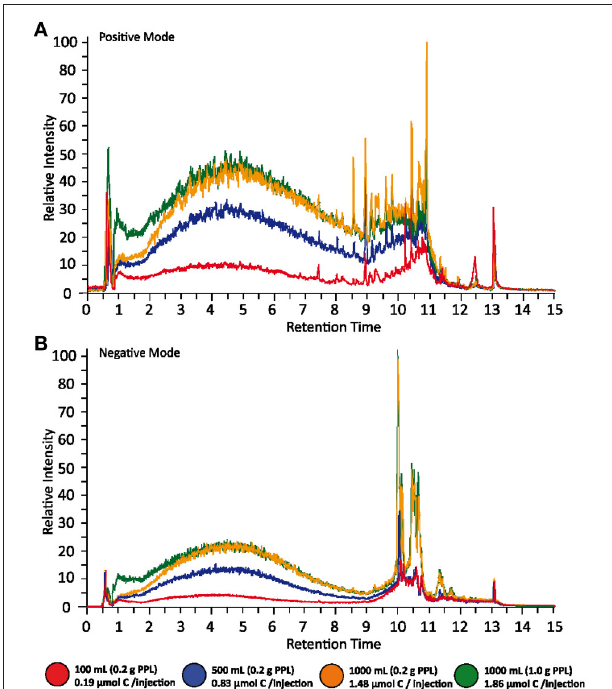
FIGURE 2 | Total Ion Current (TIC) of different extraction volumes in positive (A) and negative (B) mode. Representative LC-MS chromatograms of five replicates of different water volumes are shown. Data was acquired in both positive and negative ionization mode. The relative TIC intensity is directly related to the abundance of analytes and shows a clear trend between the different amounts of total carbon injected. The signals of one liter samples extracted with different extraction cartridges (0.2 vs. 1.0g bed mass) show the biggest difference in the lower retention time range, indicating that biases due to MS based extraction efficiencies mainly affects polar